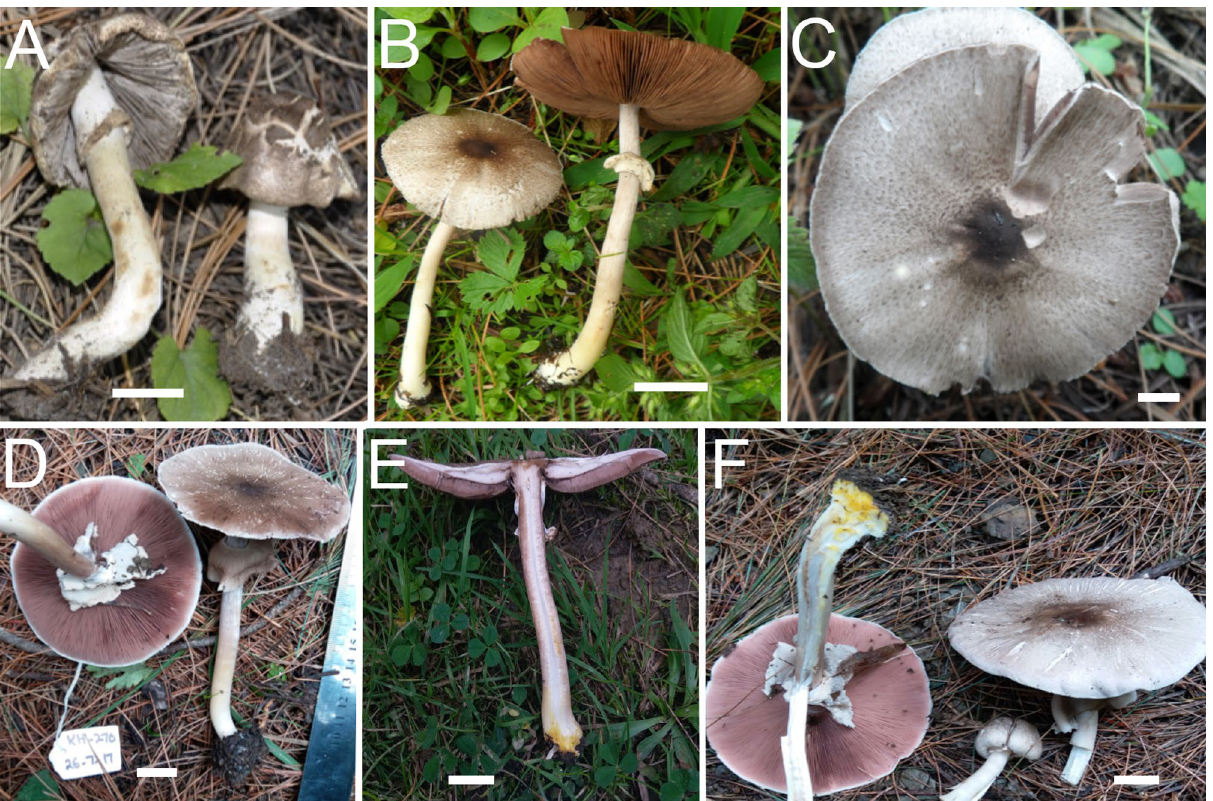
Figure 16. Macromorphological characters of A. swaticus (A–C) and A. xanthochromaticus (D–F) . (A–F) Basidiomata in the field. (A) SJ60 ( Holotype ); (B,C) SA111; (D) KH262 ( Holotype ); (E) KH270; (F) KH295. Bars = 1 cm. Photographed by Dr. Hira